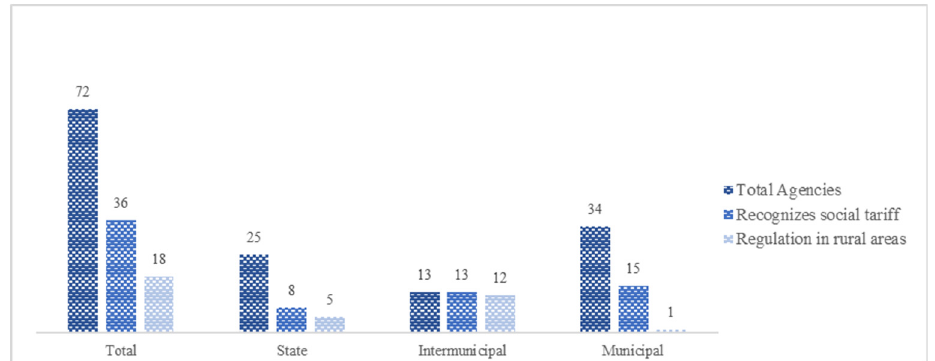
Figure 3. - Regulatory Agency in Brazil by scope, with regulatory instrument for social tariff and